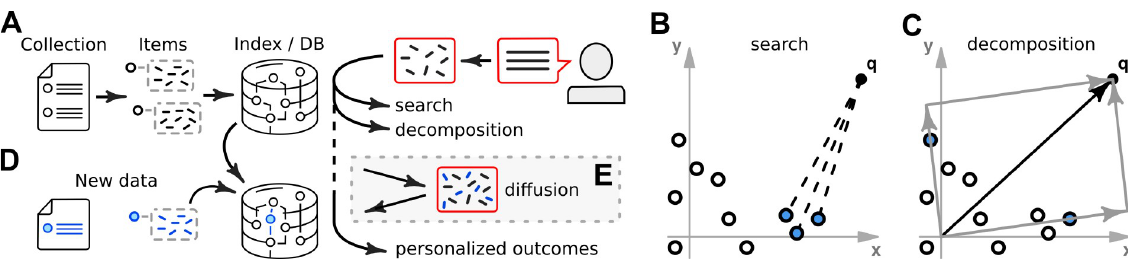
Fig 1. Knowledge-base setup and user interactions. (A) A collection of data is parsed into data items, which are split into k-mers. Data items are then inserted into a database and indexed. User queries are also parsed into k-mers and then processed using search and decomposition algorithms. (B) Schematic of a search query in a feature space. A user query, q, is compared to a collection of items (circles). The search algorithm reports a number of items that are closest to the query (blue circles). (C) Schematic of query decomposition, which returns distinct data items that, together, can reproduce the query. (D) New data items are inserted into the database in a way that preserves their status as user-specific. (E) A diffusion process augments user queries with imputed features, including features based on user-specific data, and provides a mechanism to personalize